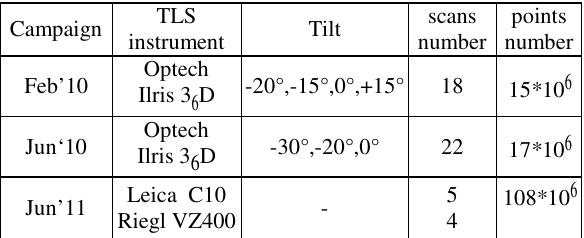
Figure 5. Synthesis of